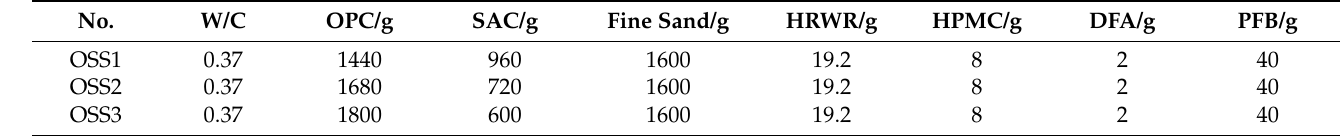
Table 2. Mix proportions of the printing mortar.